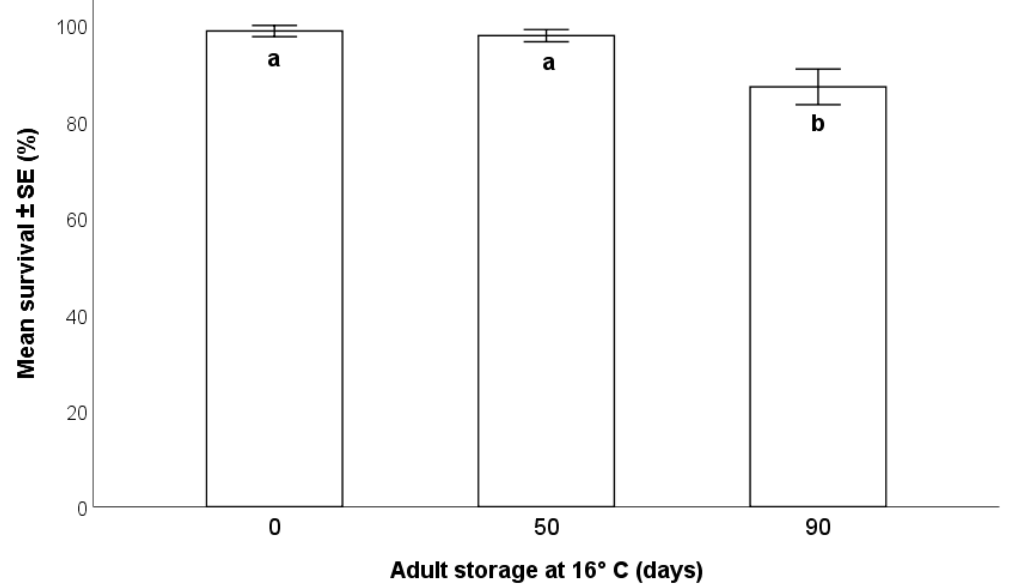
Figure 6. Effects of the length of storage at 16 °C on Trissolcus japonicus survival (GLM, p < 0.001) Different letters indicate significant differences ( p < 0.05) as detected by multiple comparison with sequential Bonferroni adjustment.